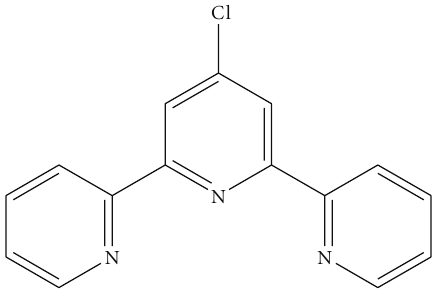
Figure 1: Structure of Cltpy ligand.